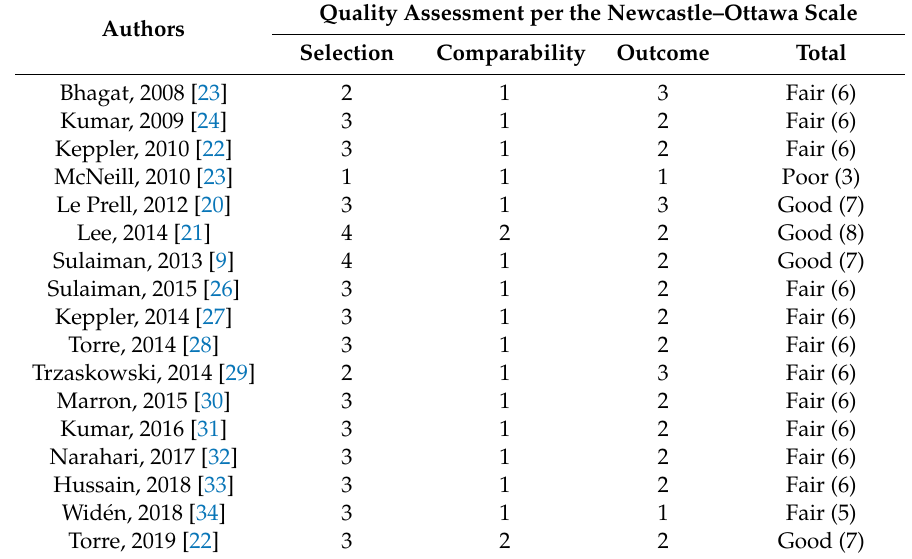
Table 2. Scientific study validity criteria based on the Newcastle–Ottawa scale used for cohort studies.